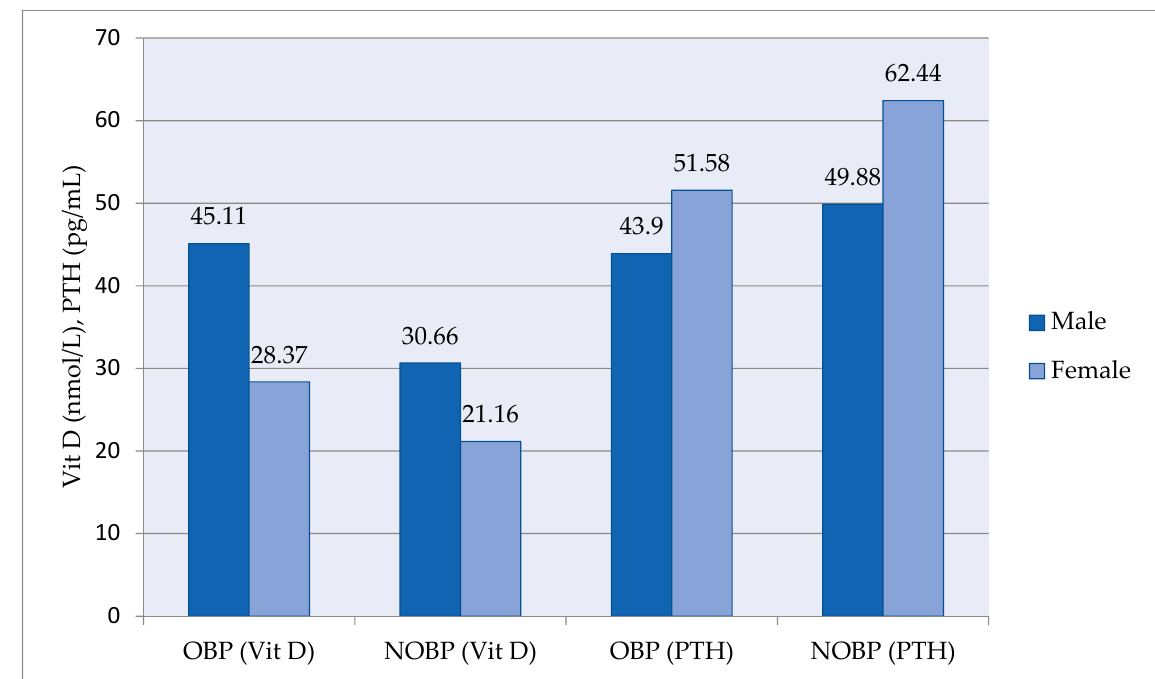
Figure 2. Distribution of vitamin D levels by groups. OBP, optimal blood pressure; NOBP, non-optimal blood pressure.